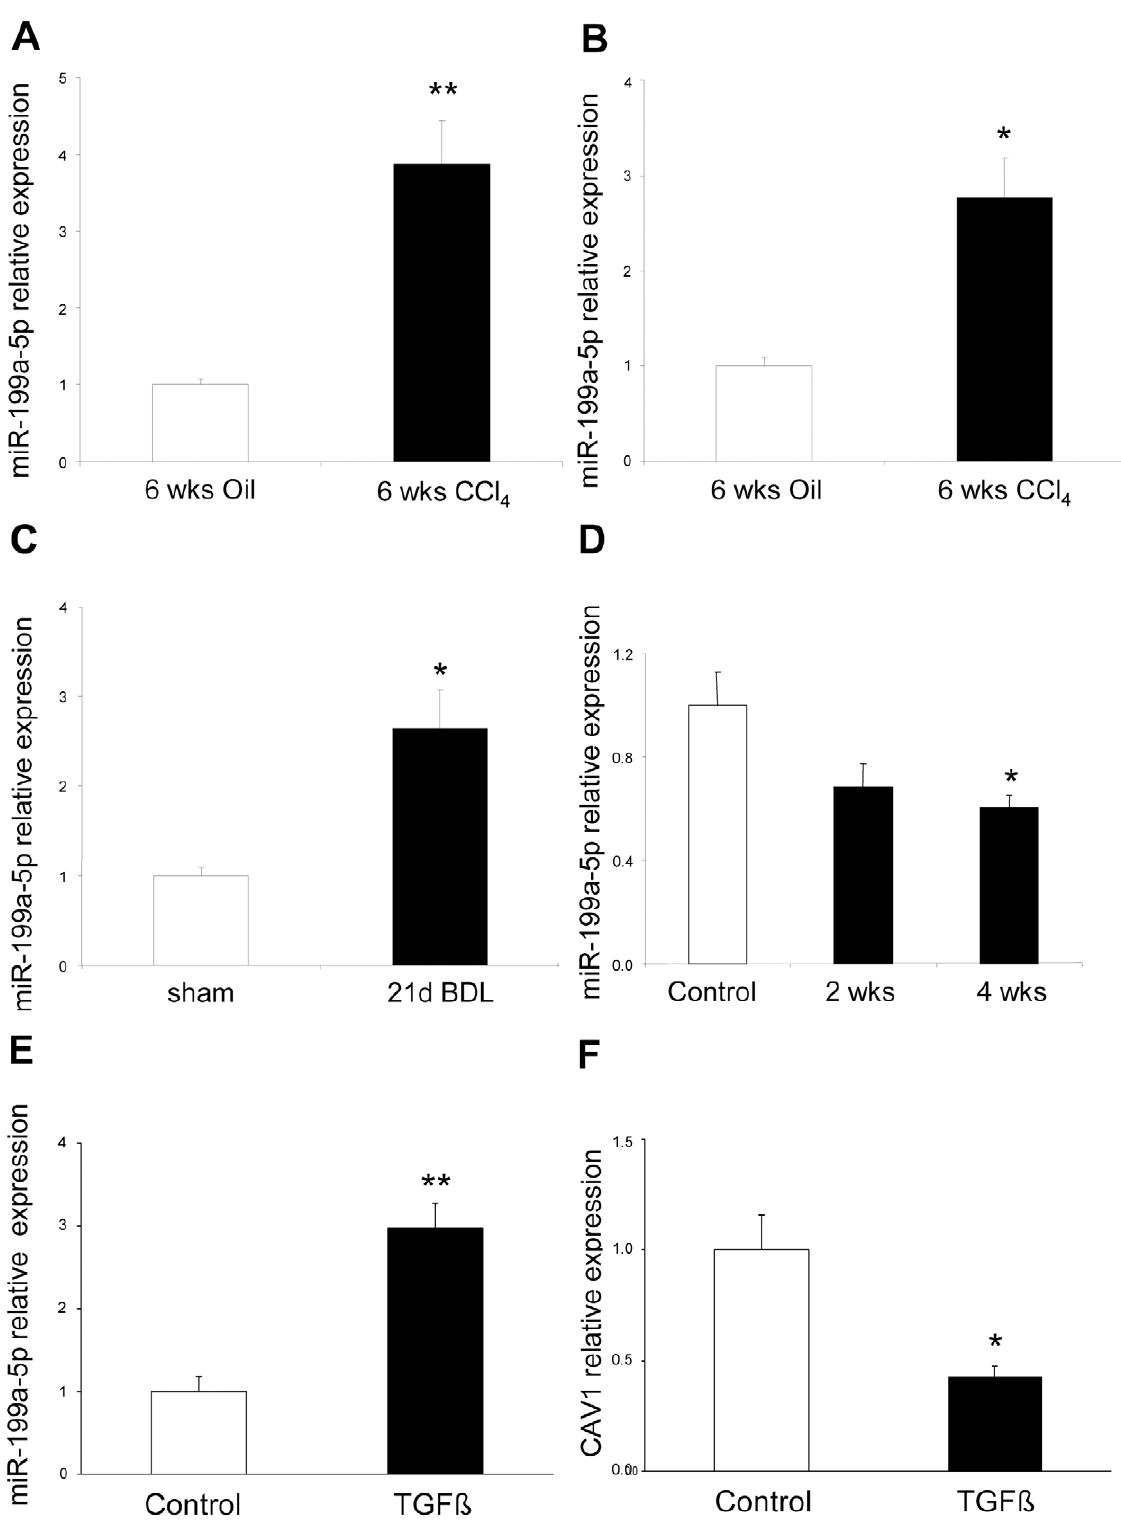
Figure 10. Altered expression of miR-199a-5p in CCl 4 induced liver fibrosis mouse model. (A) Expression of miR-199a-5p in livers from 6 weeks CCl 4 -treated or oil-treated BALB/C mice was analyzed by qPCR; n=5 per group. Data are expressed as mean 6 SEM. ** p , 0.01. (B) Expression of miR-199a-5p in livers from 6 weeks CCl 4 -treated or oil-treated C57BL/6 mice was analyzed by qPCR; n=5 mice per group. Data are expressed as mean 6 SEM. * p , 0.05. (C) Expression of miR-199a-5p in livers from C57BL/6 mice 21 days following bile duct ligation or sham operation was analyzed by qPCR; n=4 mice per group. Data are expressed as mean 6 SEM. * p , 0.05. (D) Expression of miR-199a-5p in liver of C57BL/6 mice during fibrosis regression. Liver fibrosis was induced by injection of CCl 4 and expression of miR-199a-5p was assessed 6 weeks after CCl 4 treatment as well as